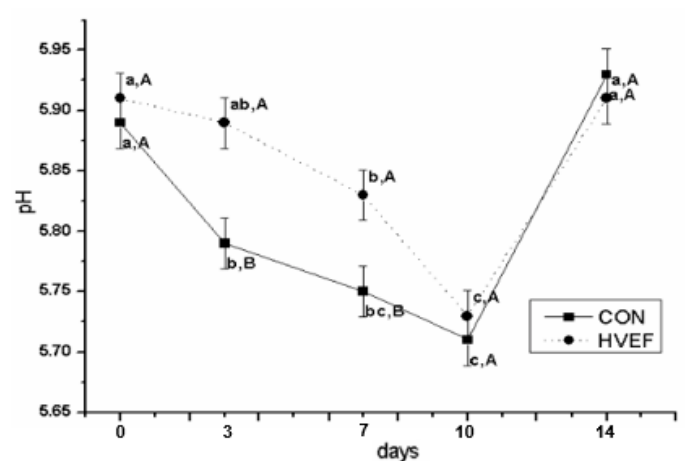
Figure 1. Influence of high ‐ voltage electrostatic field (HVEF) on pH value of dry ‐ cured beef during storage. Different capital letters indicate significant differences ( p < 0.05) between treatments in the same time and small letters indicate significant differences ( p < 0.05) between times in the same treatment. Error bars reflect standard errors.